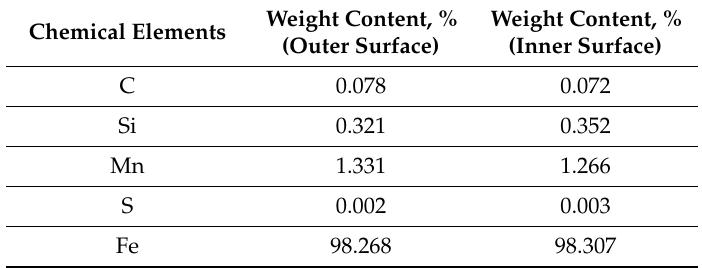
Table 4. Elemental composition of the outer and inner surfaces in the untreated